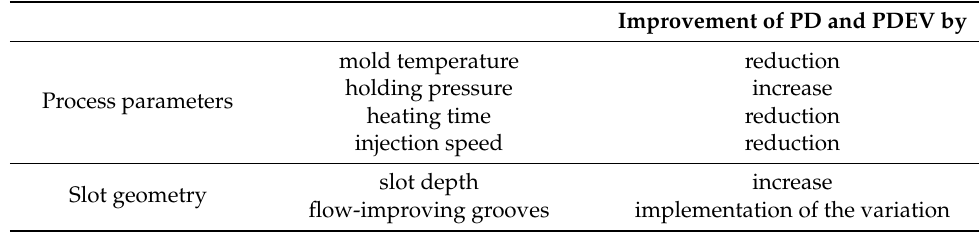
Table 2. Improvement in PD and PDEV in the insulation system of the single slot sample by process conditions and slot geometry.